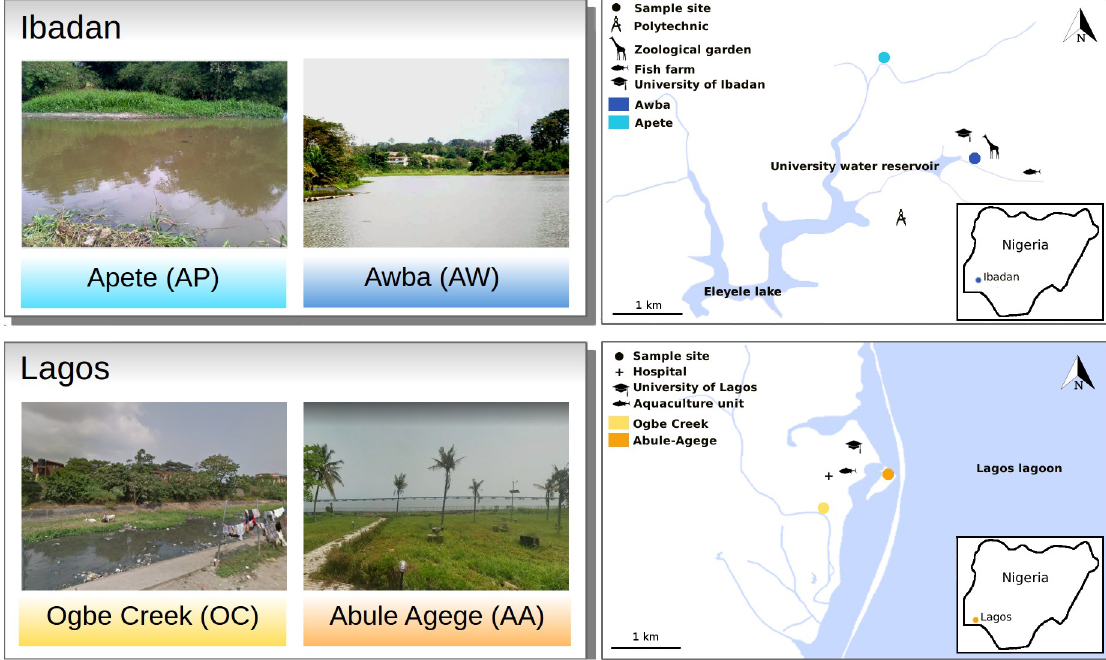
Fig 1. The study sites showing Awba wetland (AW), Apete wetland (AP), Abule-Agege wetland (AA) and Ogbe Creek (OC).